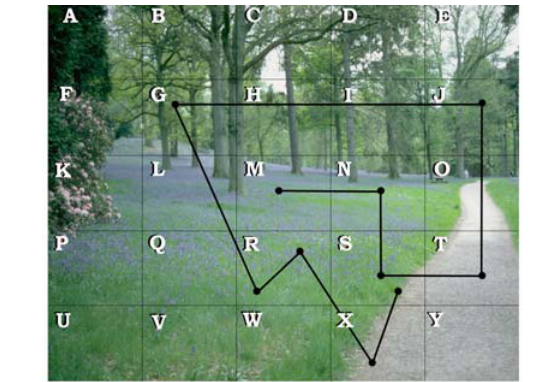
Figure 9: an example of the 5-by-5 grid on top of a pho- tograph. An example fixation sequence has been drawn, with the initial fixation in the centre of the picture (grid box